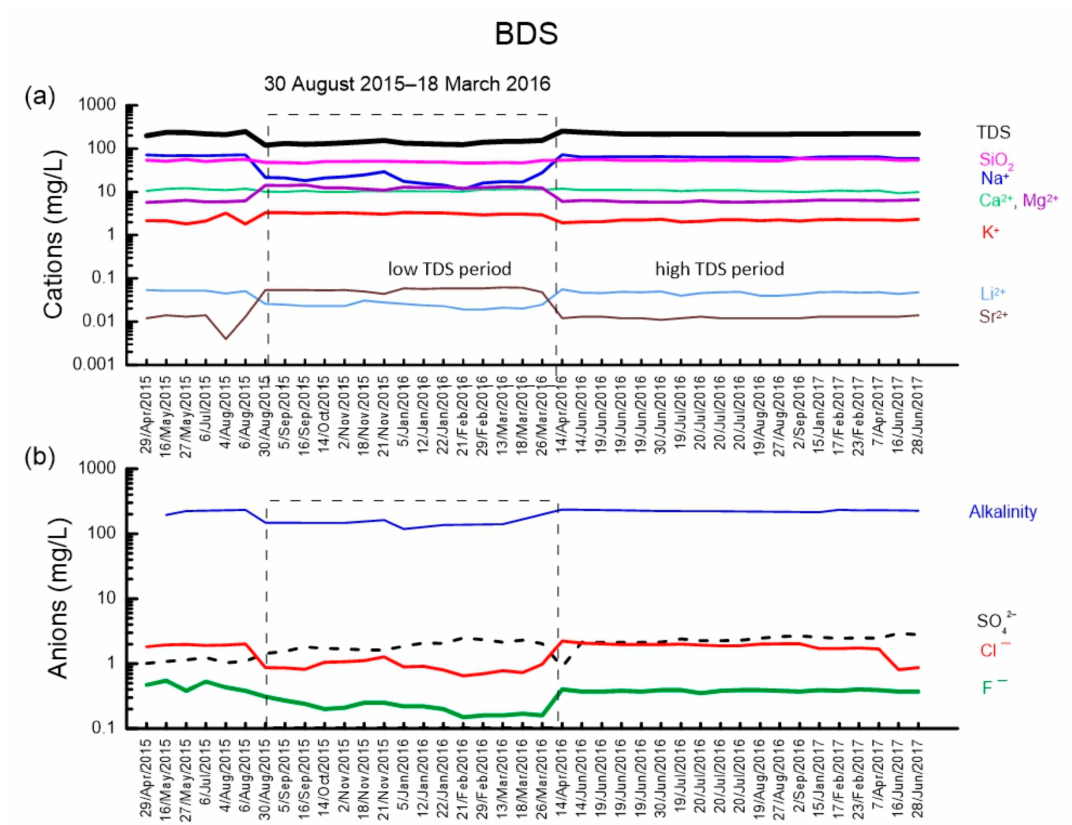
Figure 3. Variation diagram of ( a ) cations and ( b ) anions in the BDS bottled waters from April 2015 to September 2016.